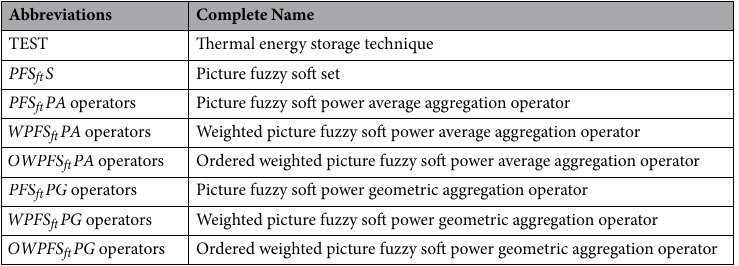
Table 8. Expressions of the abbreviations in this manuscript.